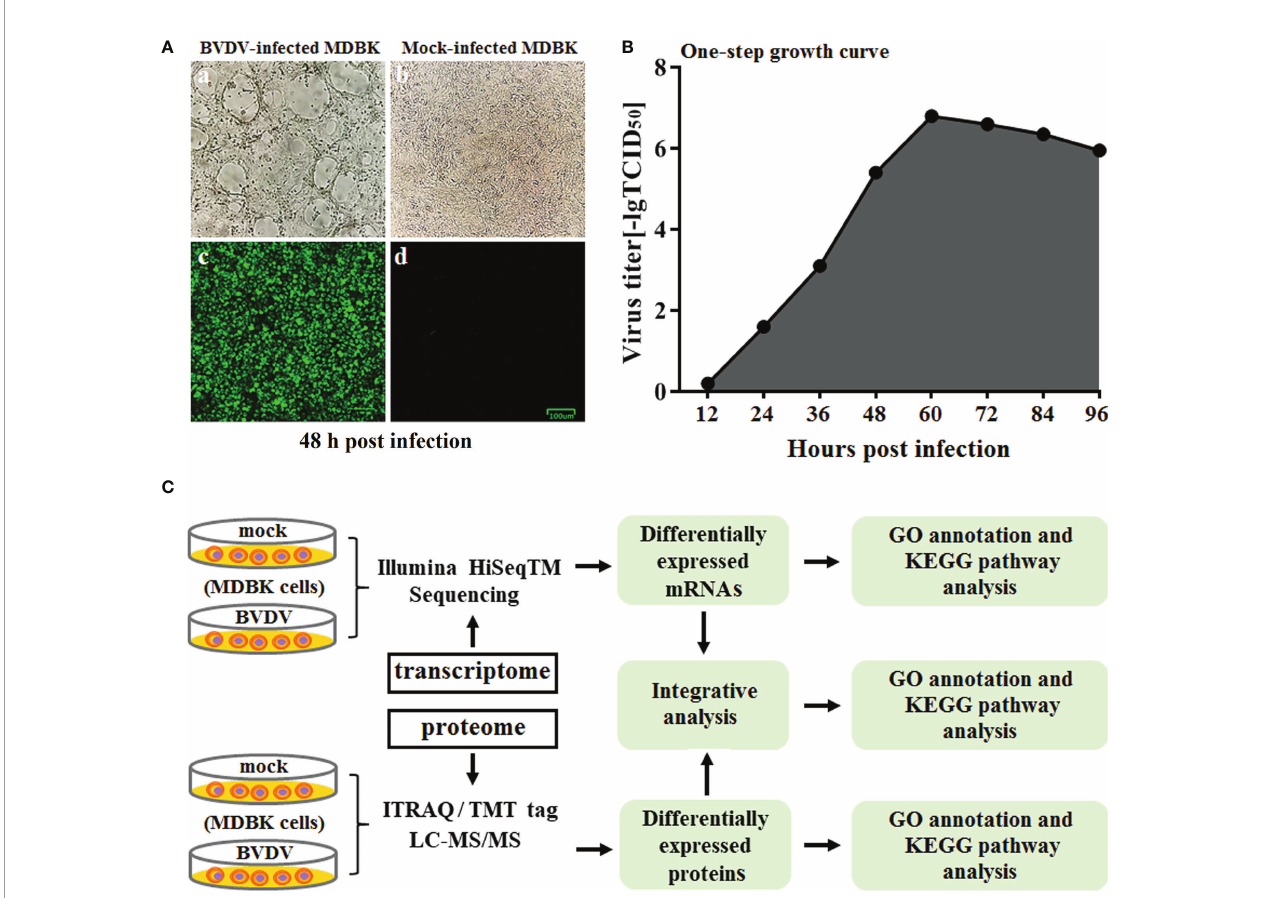
FIGURE 1 | (A) Virus identi fi cation. a: CPE of BVDV strain AV69; b: mock-infected MDBK cells; c: identi fi cation of BVDV by IFA; d: IFA results for mock-infected MDBK cells. (B) One-step growth curve of BVDV strain AV69 in MDBK cells. (C) Schematic diagram of the transcriptomic and proteomic sequencing work fl